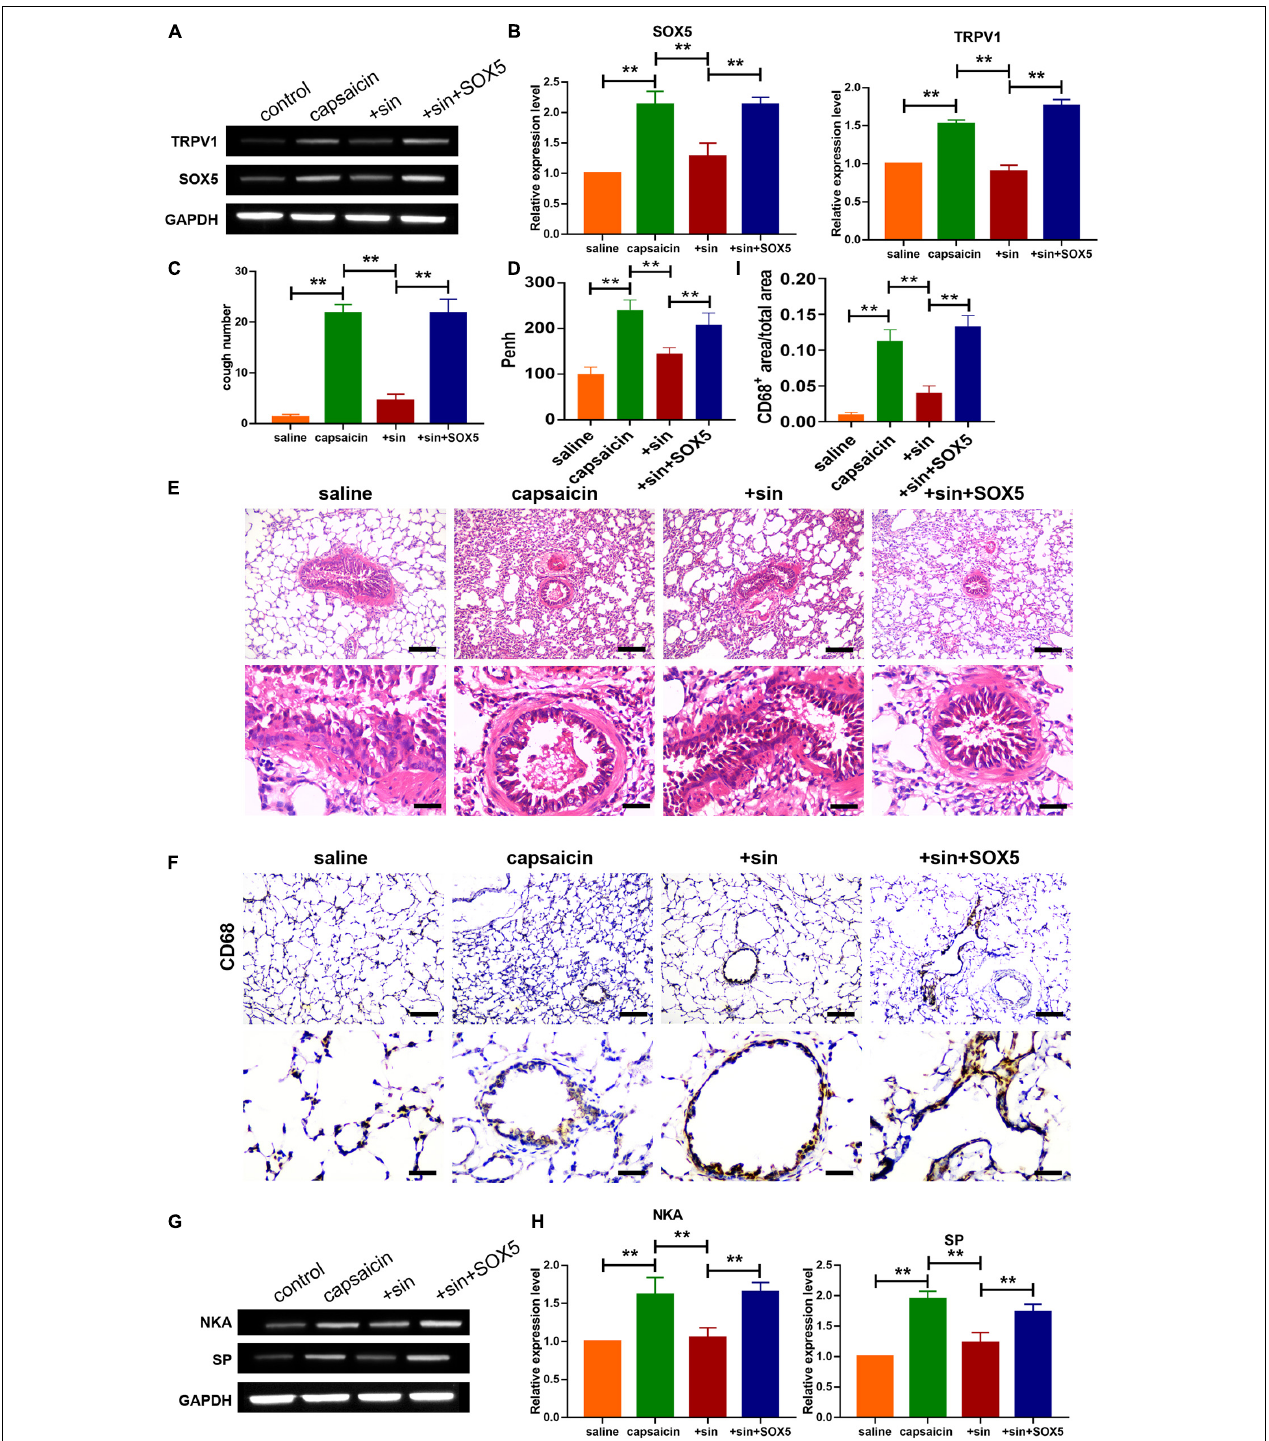
FIGURE 6 | Effect of sinomenine on capsaicin-induced increase in cough sensitivity in guinea pigs, and the implication of SOX5 and TRVP1 in the process. (A,B) Protein expression levels of TRPV1 and SOX5 in guinea pigs, as assayed using western blotting. Data are mean ± SEM; one-way ANOVA was used for statistical analysis. (C) CRS in guinea pigs showing that treatment by sinomenine and SOX5 increased the number of cough. Data are mean ± SEM; one-way ANOVA was used for statistical analysis. (D) SOX5 administration enhanced Penh. Data are mean ± SEM; one-way ANOVA was used for statistical analysis. (E) H&E staining showing levels of inflammatory cell infiltration. Scale bars represent 50 and 100 µ m. (F,I) CD68 staining indicating that SOX5 increased the infiltration of monocytes/macrophages. Scale bars represent 50 and 100 µ m. (G,H) Western blot analysis showing the expression levels of SP and NKA in guinea pigs. Data are mean ± SEM; one-way ANOVA was used for statistical analysis. ** P < 0.01; n = 7.